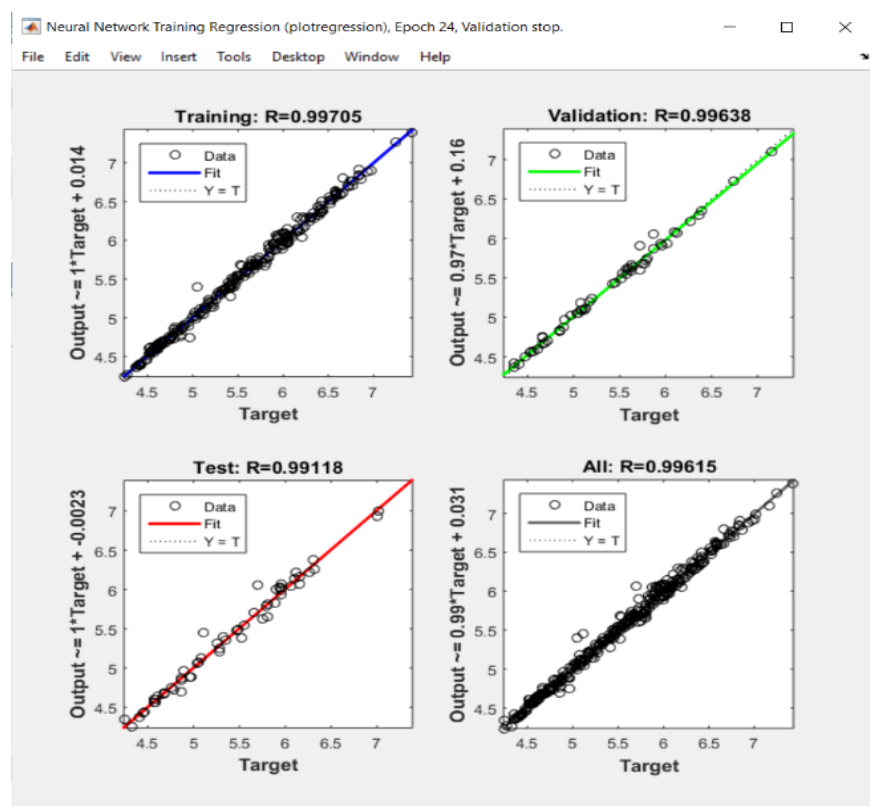
Figure 4. Regression coefficients of the learning process of the ANN.